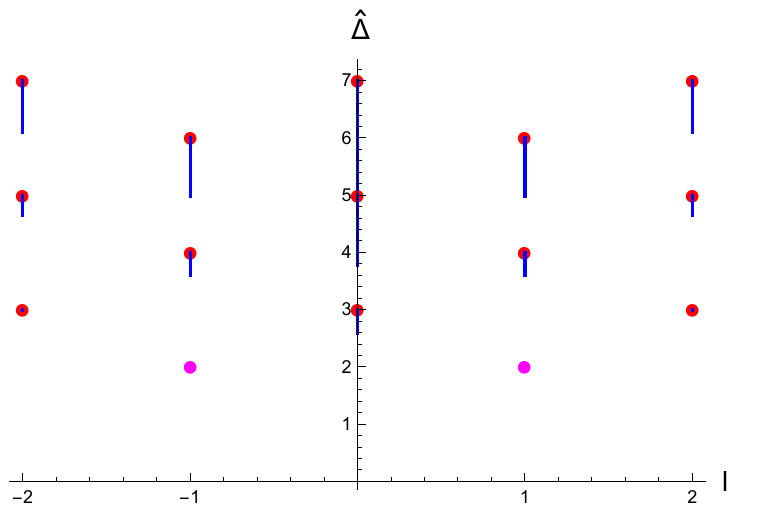
Figure 5 . Plot of (cid:1) vs l , for the defect operators that appear in the dOPE of the stress tensor for a holographic model. The red dots are the values at n = 1 and these results are universal to any b CFT. The blue lines show the change in the values of the scaling dimension for n displacement operator (shown in pink), which has a protected scaling dimension of appears only for n = 6